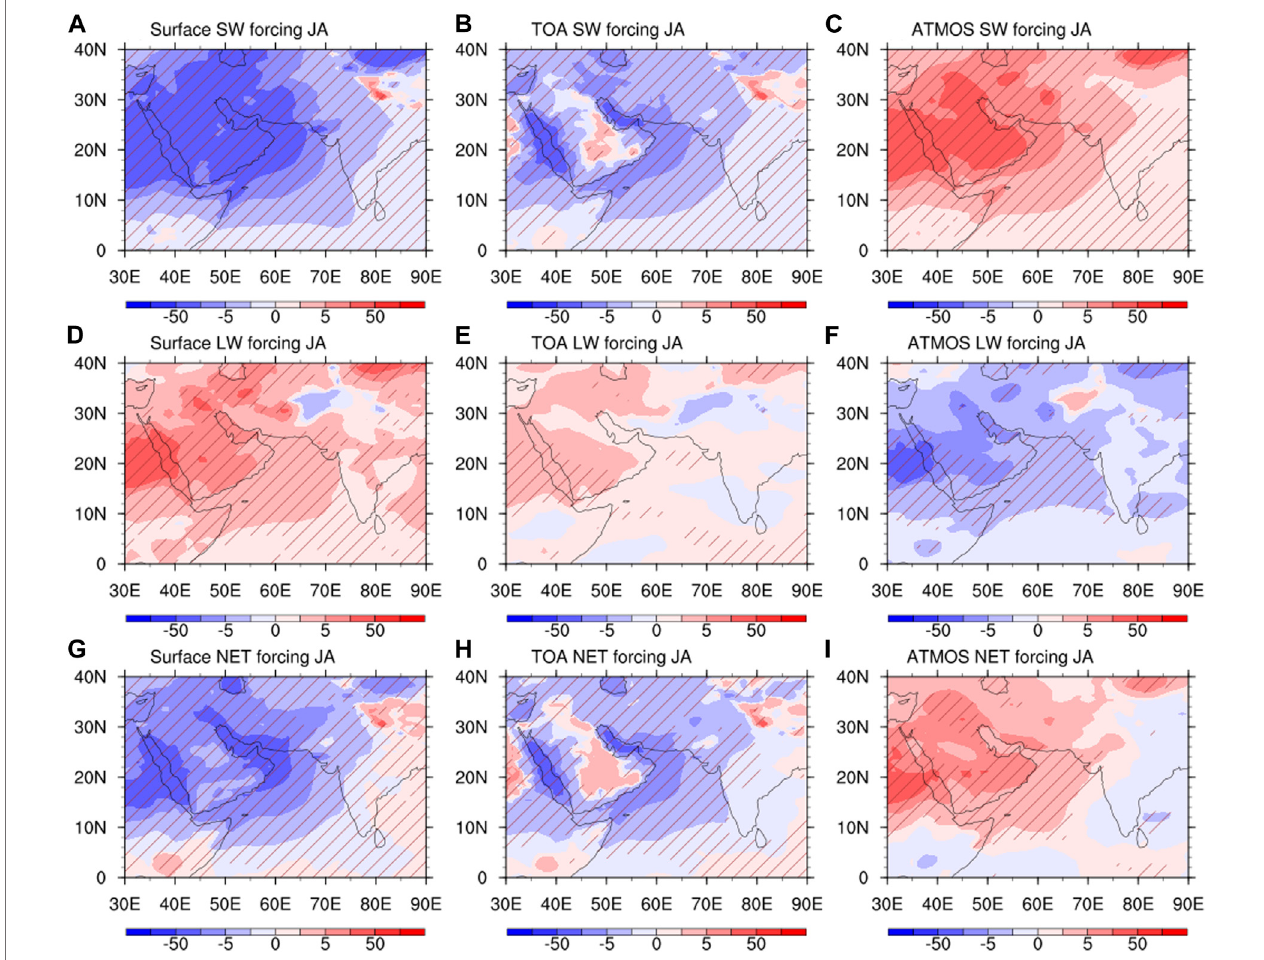
FIGURE 11 | The dust DRE induced changes (UMD − UMN) in clear-sky short-wave [SW, (A – C) ], long-wave [LW, (D – F) ] and net [SW + LW, (G – I) ] radiative forcing (W/m 2 ) at the surface (A,D,G) , at the TOA (B,E,H) and in the atmosphere (C,F,I) in the late monsoon. Brown lines represent the values statistically signi fi cant at the 0.1